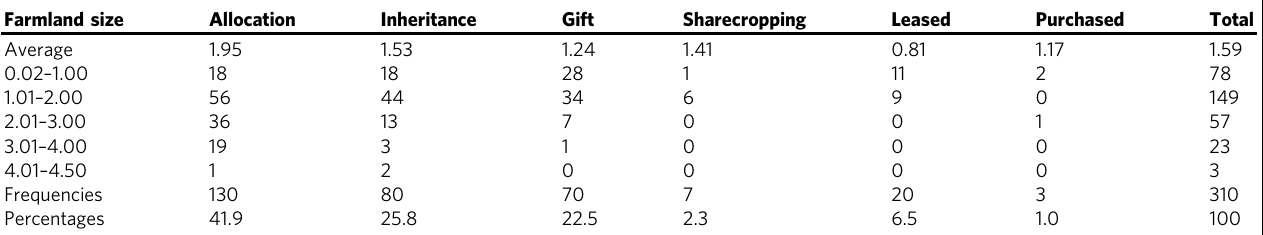
Table 6 Households tenure